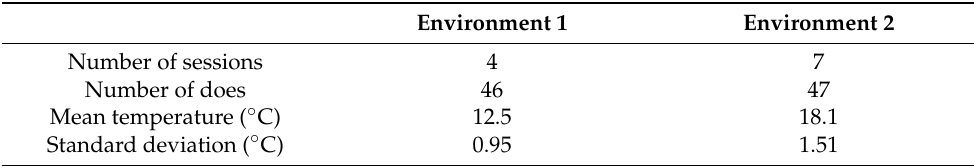
Table 1. Distribution of thermographic sessions according to environmental